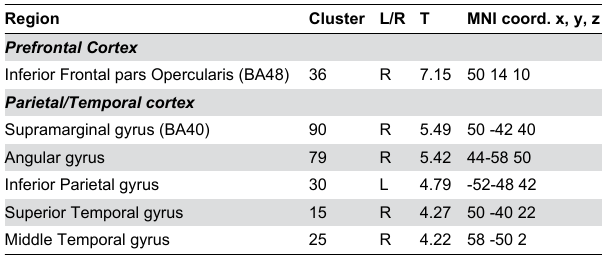
BA = Broadmann area; R=right, L=left; MNI coordinates represent cluster